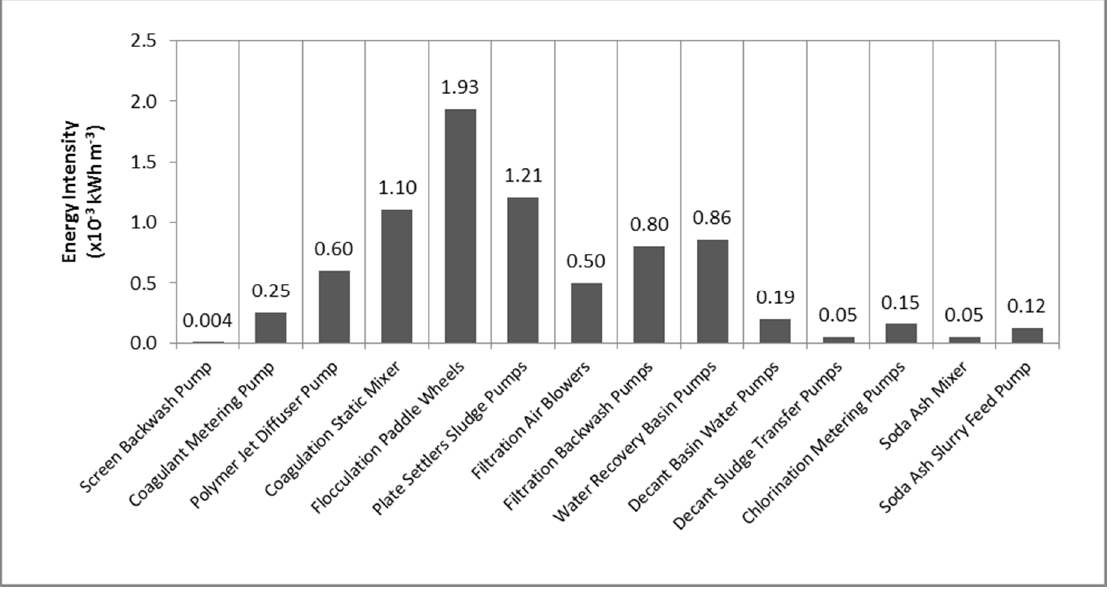
Figure 3. Results generated for the energy intensity of various unit processes of the drinking water treatment plant.